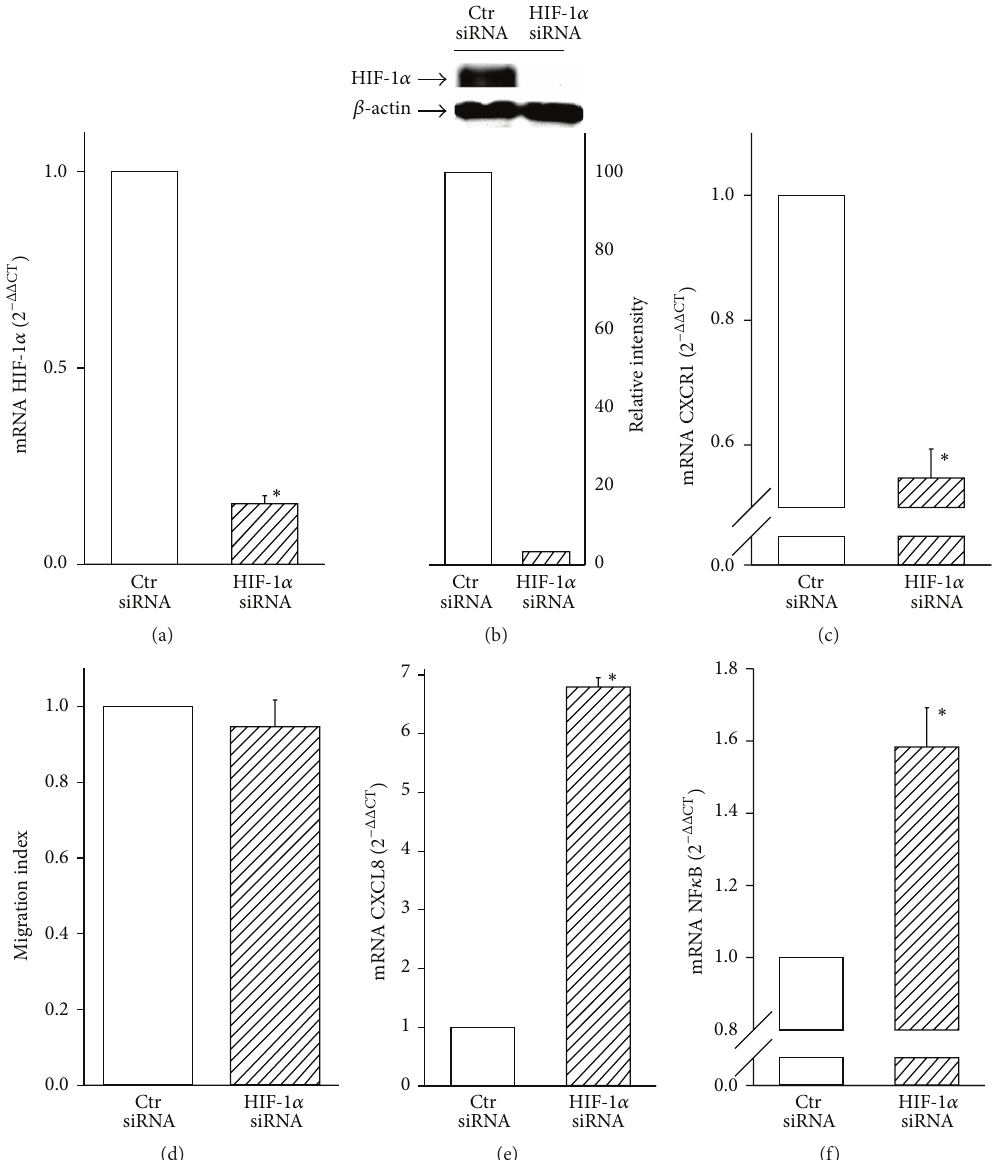
Figure 2: HIF-1 𝛼 siRNA does not affect IL-1 𝛽 -induced cell migration in hypoxia. Data are shown as means ± SEM. ∗ 𝑃 < 0.05 , statistically significant difference between IL-1 𝛽 -treated hypoxic cells silenced for HIF-1 𝛼 (HIF-1 𝛼 siRNA) and IL-1 𝛽 -treated hypoxic cells silenced with oligo controls (Ctr siRNA). (a) HIF-1 𝛼 mRNA expression was determined by qRT-PCR analysis ( 𝑛 = 3 ). (b) Protein expression of HIF-1 𝛼 was determined by Western blot analysis. 𝛽 -actin was used as loading control. A representative blot from three independent experiments was shown. Quantification of HIF-1 𝛼 protein expression was achieved by chemiluminescence. (c) CXCR1 mRNA expression was determined by qRT-PCR analysis ( 𝑛 = 3 ). (d) The migration index was calculated as a fold change of relative CyQuant fluorescence of cells migrating into the lower chamber normalized to that of the control samples (Ctr siRNA) ( 𝑛 = 4 ). (e and f) CXCL8 and NF 𝜅 B mRNA expression was analyzed by qRT-PCR ( 𝑛 = 3